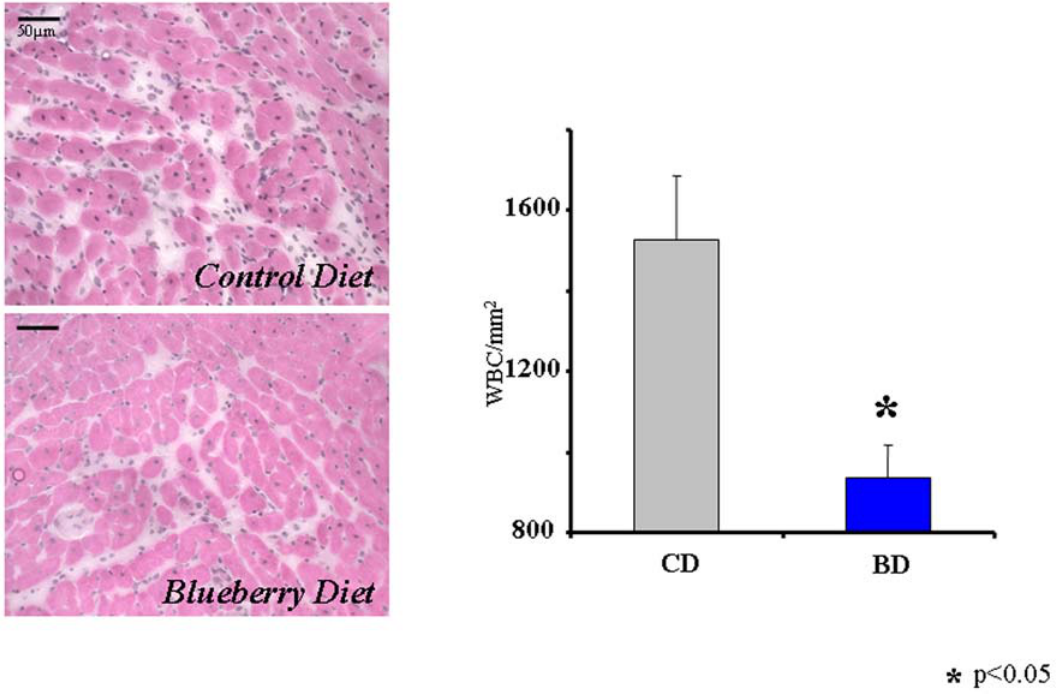
Figure 4. Inflammation in themyocardial AAR 24-hrs following permanent coronary ligation. Hematoxylene & Eosin staining. *-p , 0.01 vs CD.